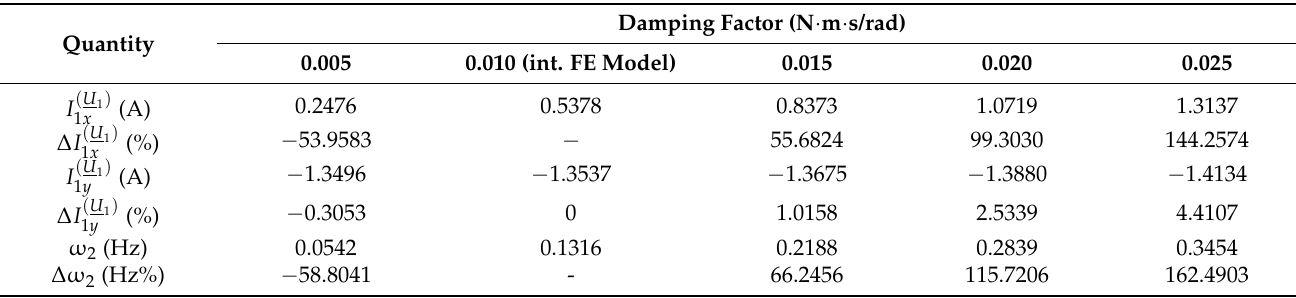
Table 2. The x -axis and y -axis components of the SC space vector and the slip frequency at the modification of the stator and rotor B-H curve slope of the FE model.